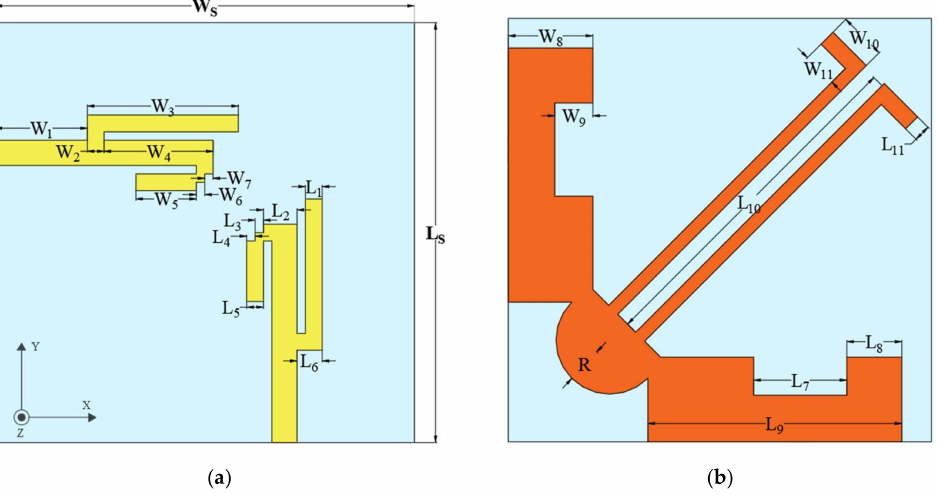
Figure 3. Structure of the designed MIMO antenna. ( a ) top view, ( b ) bottom view.